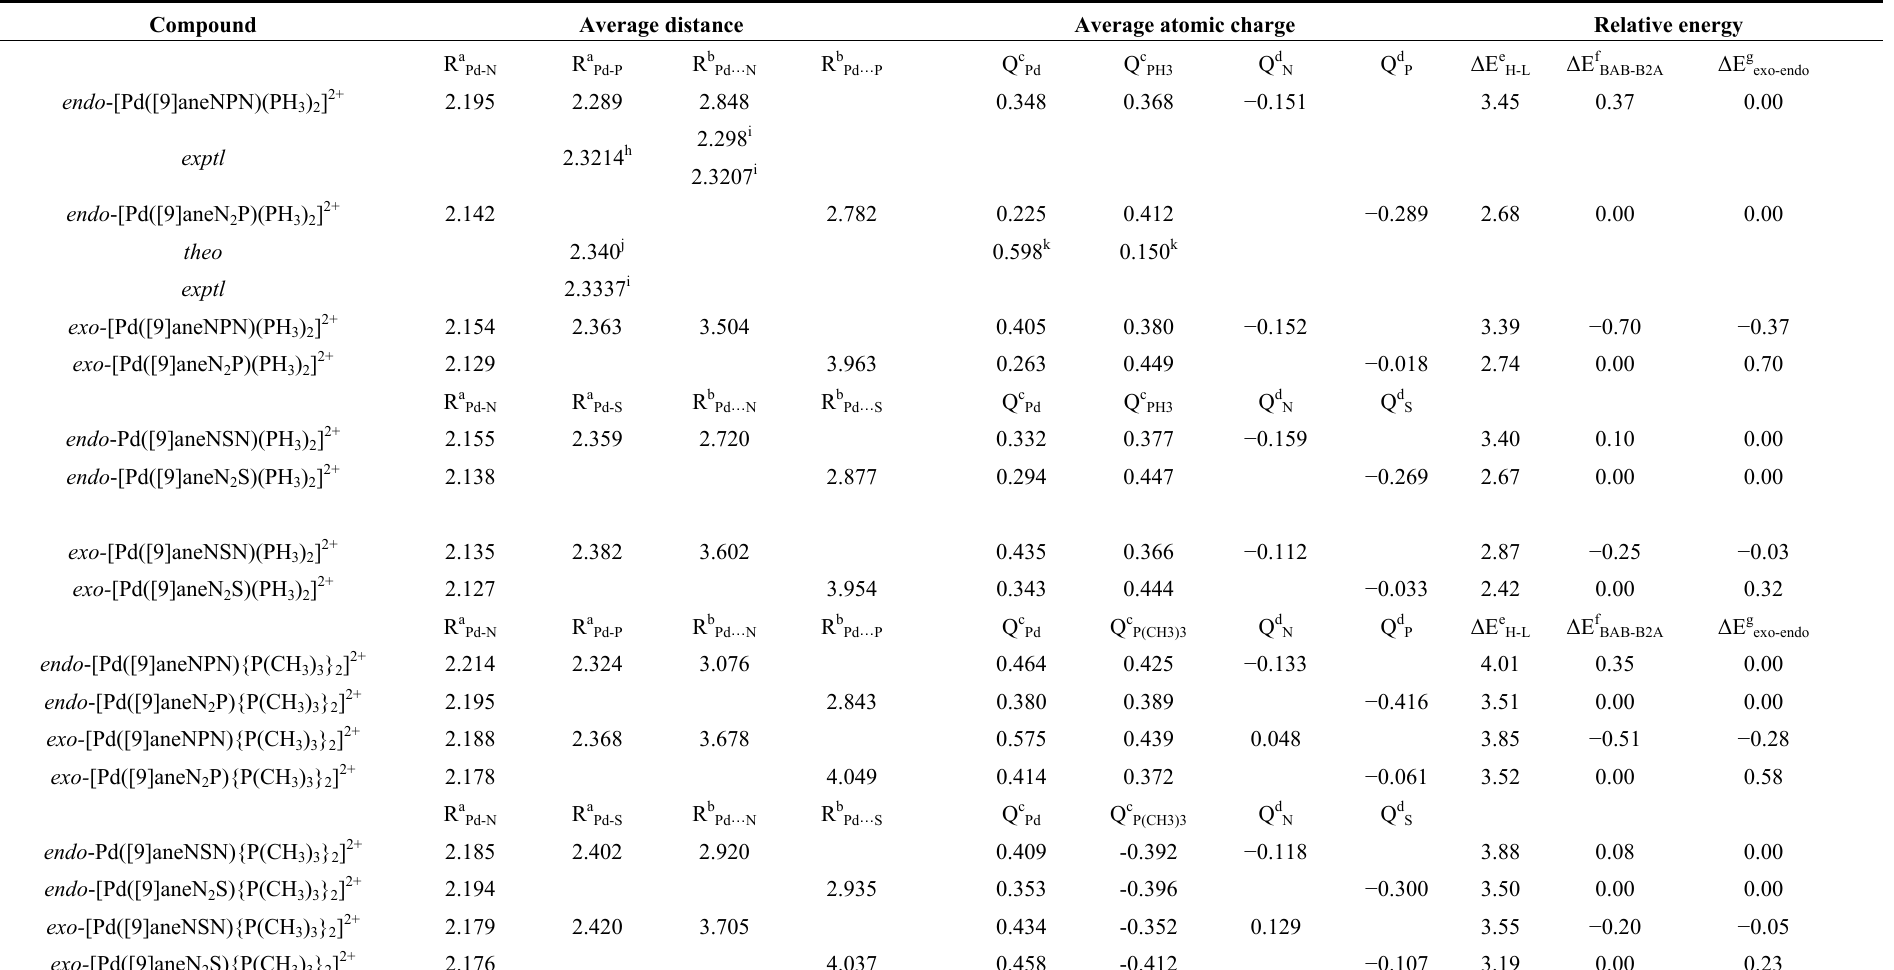
Table 1. Optimized average bond distances (Å), average atomic charges (CHelpG, au), and relative energies (eV) of the equilibrium structures of {Pd([9]ane B A ) L and Pd([9]ane BAB ) L } at the B3P86/6-311+G** (lanl2DZ for Pd) 2 2 2